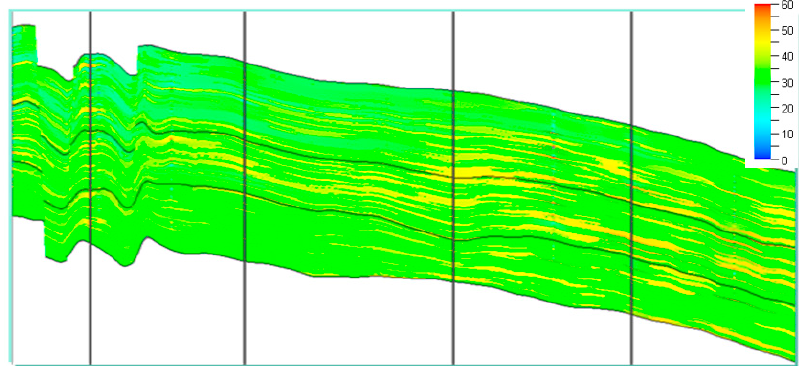
Figure 8. Cross-section map of Young’s modulus in the N–S direction.